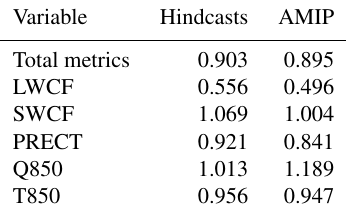
Table 3. The optimal improvement index of each variable and total comprehensive metric of the CAPT run and AMIP